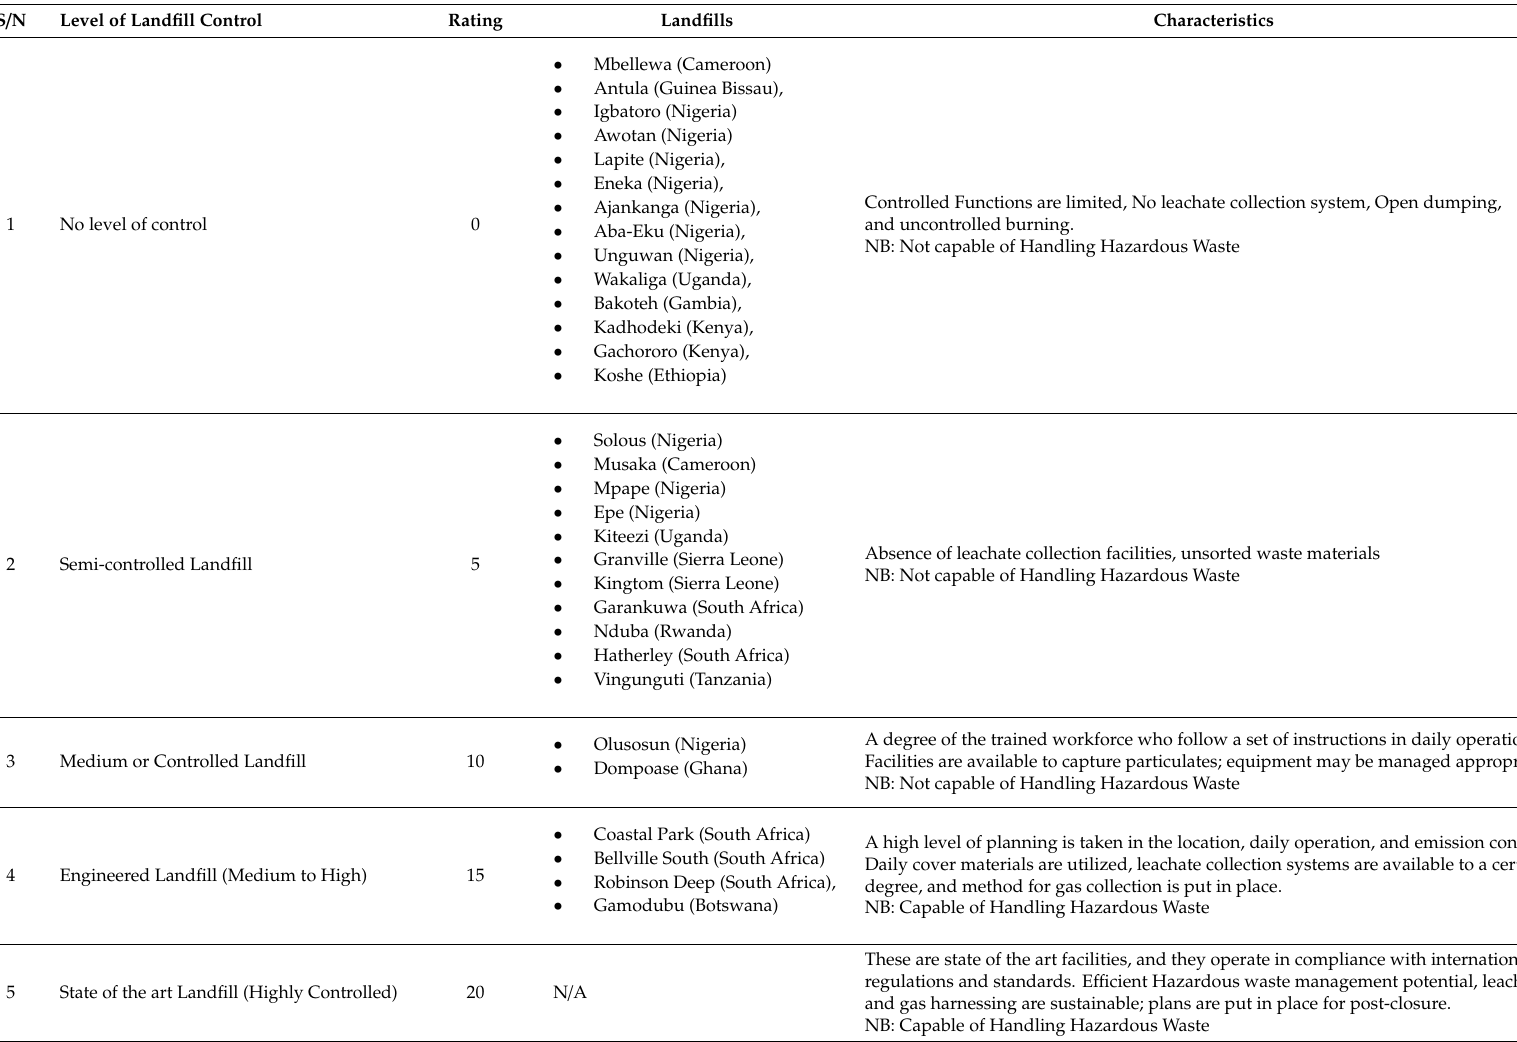
Table 5. A review of landfills in Africa and their ranking, based on the level of agreement to international rules